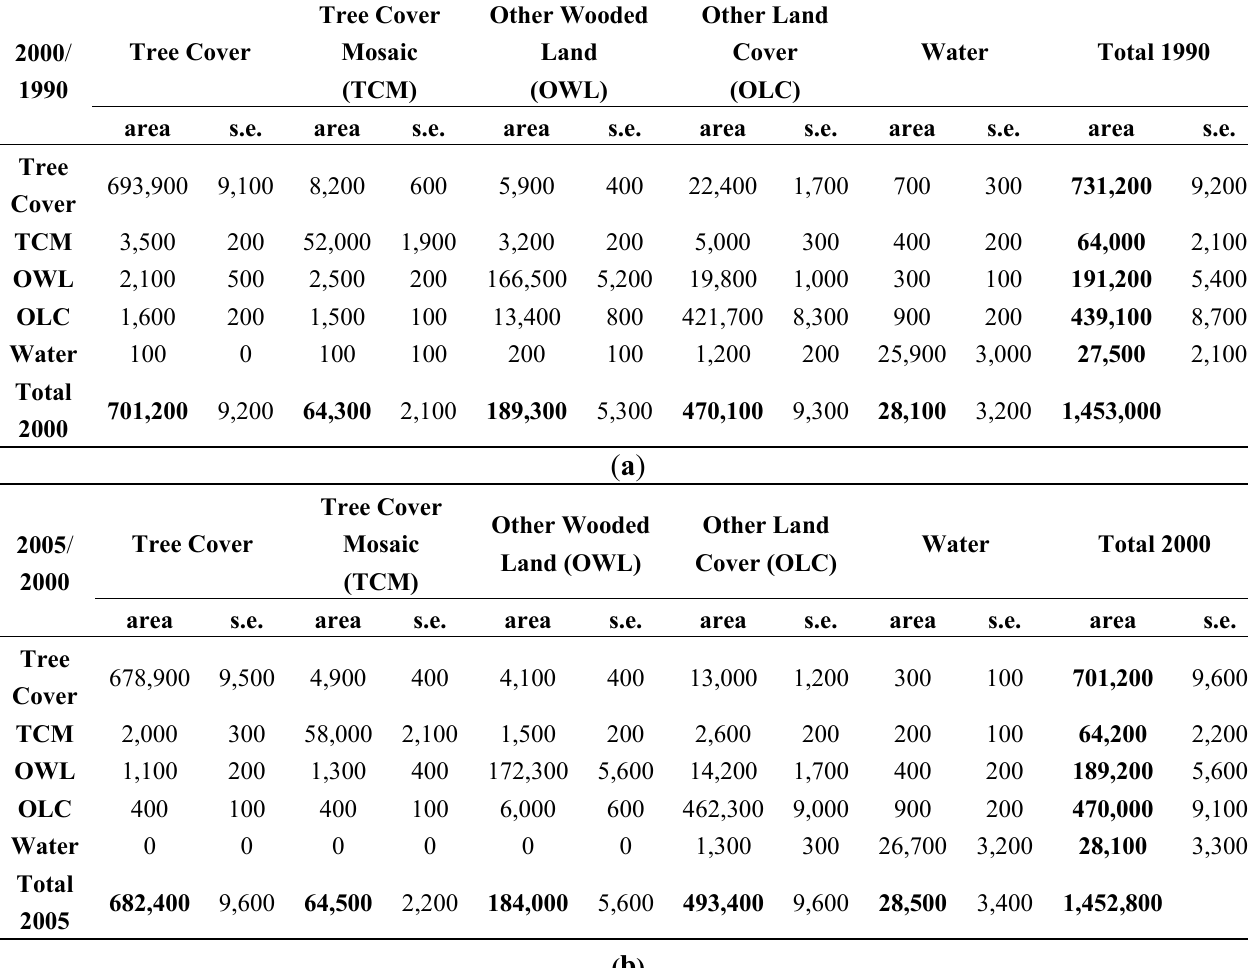
Table 2. ( a ) Land cover change matrices for the whole study area 1990–2000; ( b ) and for 2000–2005. All values in 10 6 ha.